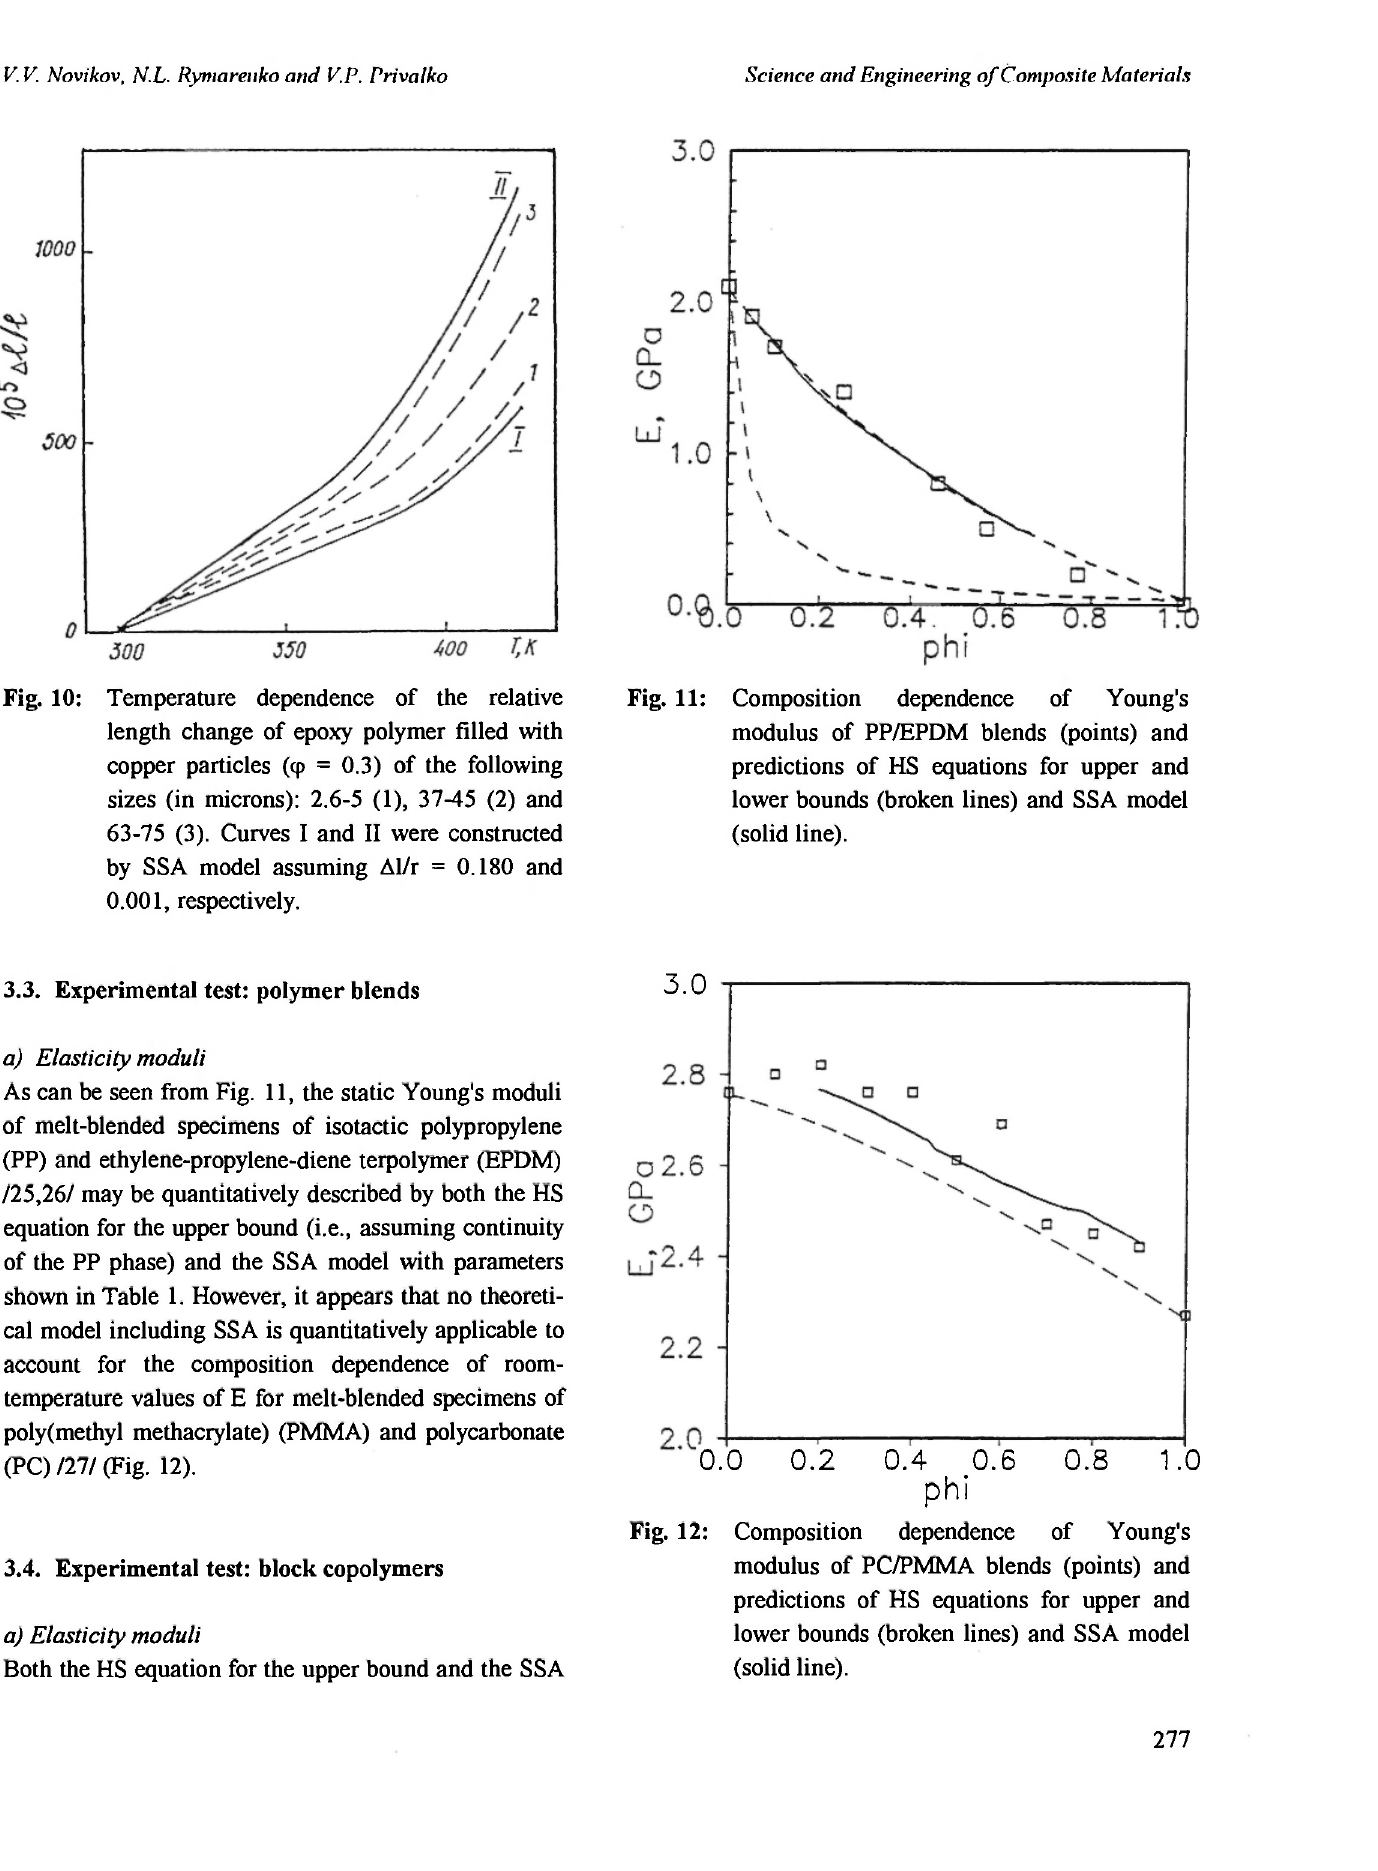
Fig. 11: Composition dependence of Young's modulus of PP/EPDM blends (points) and predictions of HS equations for upper and lower bounds (broken lines) and SSA model (solid line).